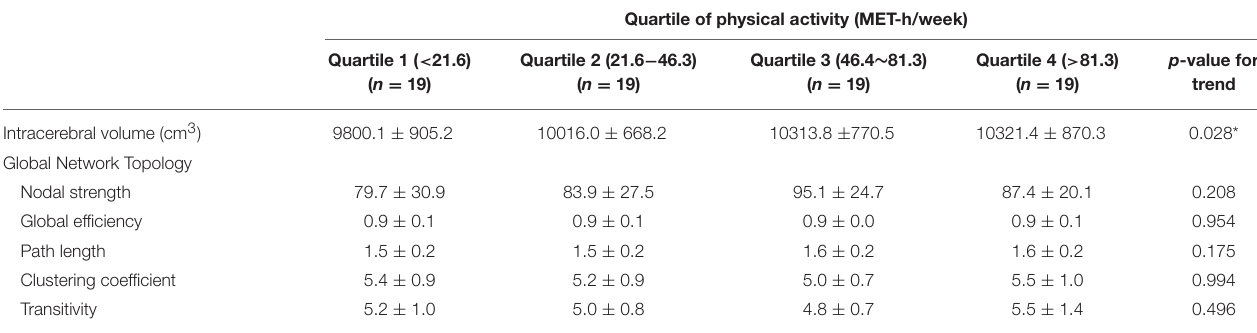
TABLE 3 | Intracerebral volume and global network topology according to physical activity quartile.